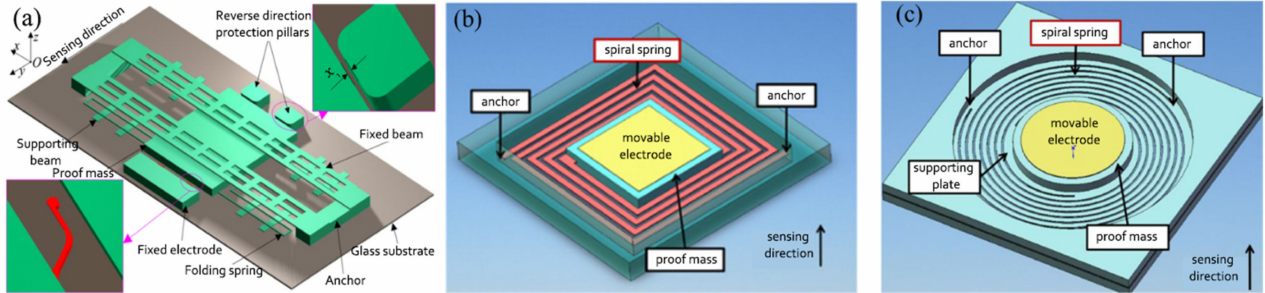
Figure 5. Schematic diagrams of three low-g inertial switches. ( a ) The nickel low-g MEMS inertial switch [57]. ( b ) The silicon-based low-g MEMS inertial switch [58]. ( c ) The lower stiffness of the redesigned inertial switch